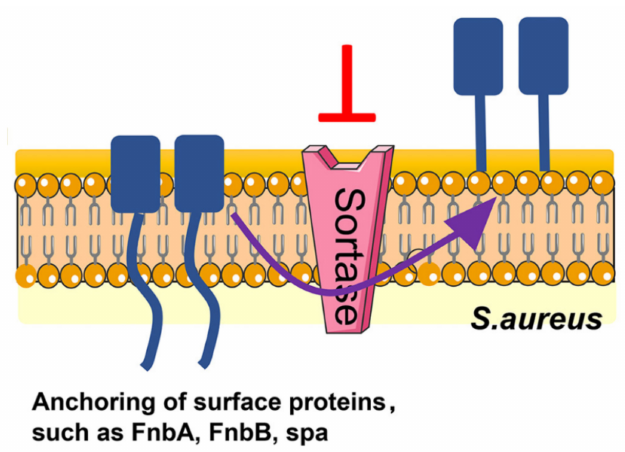
Figure A1. Representation of sortase A role